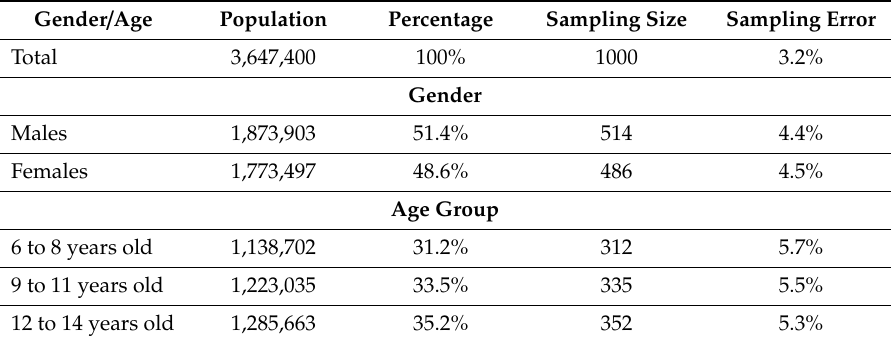
Table 1. Distribution of the sample according to age and gender.